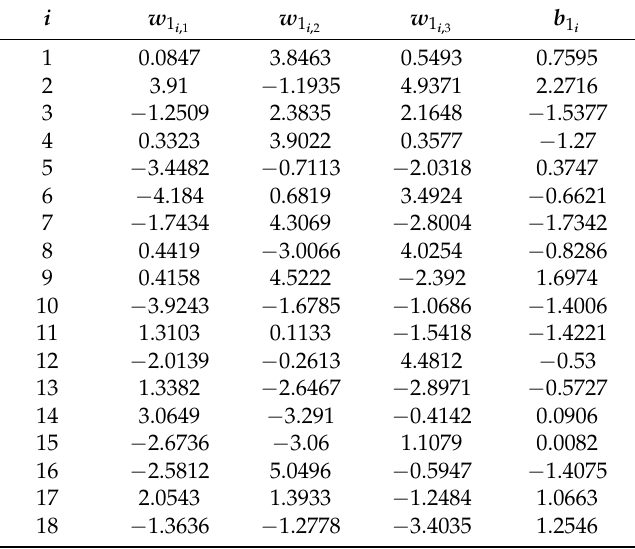
Table 2. Weights and biases of the first hidden layer in the ANN structure of the bubble point pressure